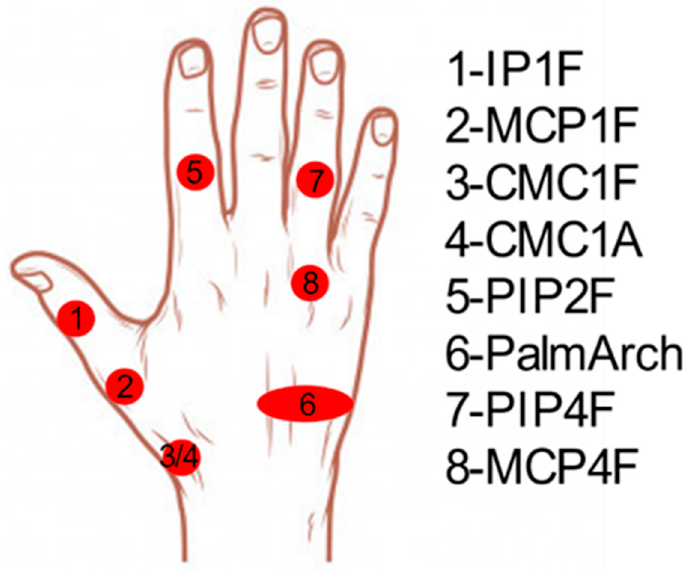
Figure 11. Best 8 DoF selected as representative angles for the estimation of the remaining hand joints. 1 to 5 refers to thumb to little fingers. F stands for flexion/extension and A for abduction/adduction movements.